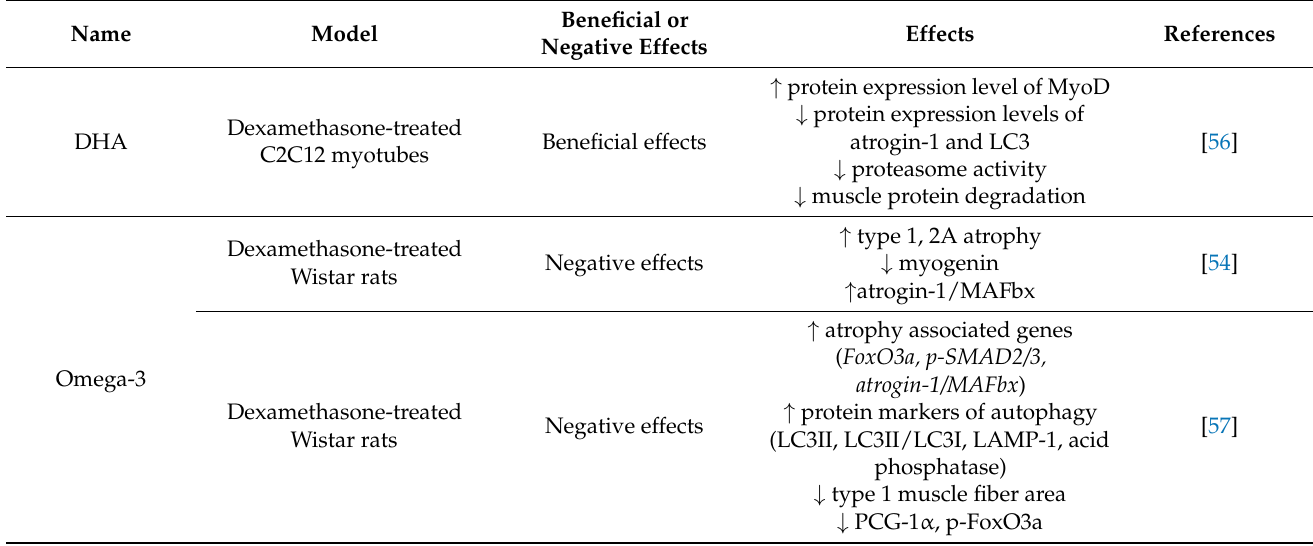
Table 2. The role of fatty acids in glucocorticoid-induced muscle